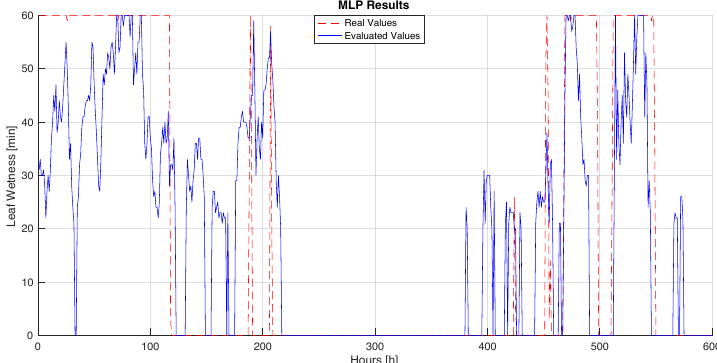
Figure 6. Comparison between leaf wetness data acquired by sensors and values evaluated with the MLP neural network, correlation coefficient R =